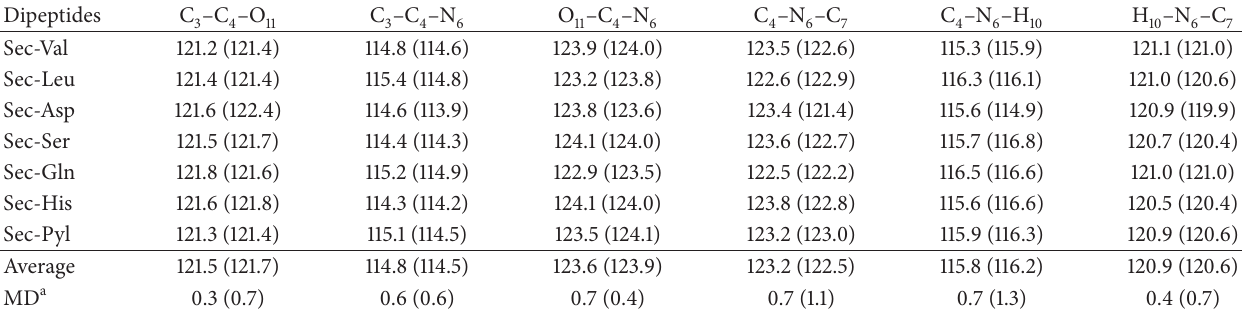
Table 3: Calculated bond angles (in degrees) for the peptide planes of the dipeptides; the gas phase values are given in brackets.